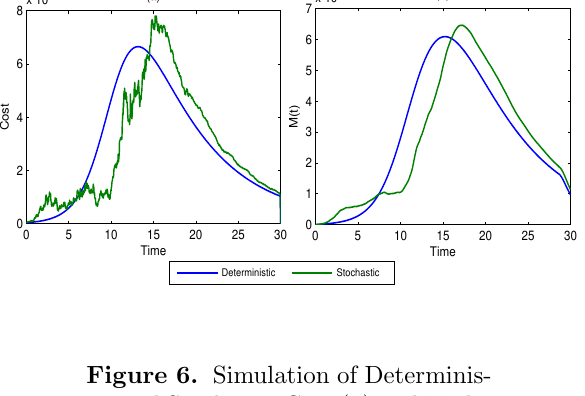
Figure 6. Simulation of Determinis- tic and Stochastic Cost ( a ) and Media campaigns ( b )